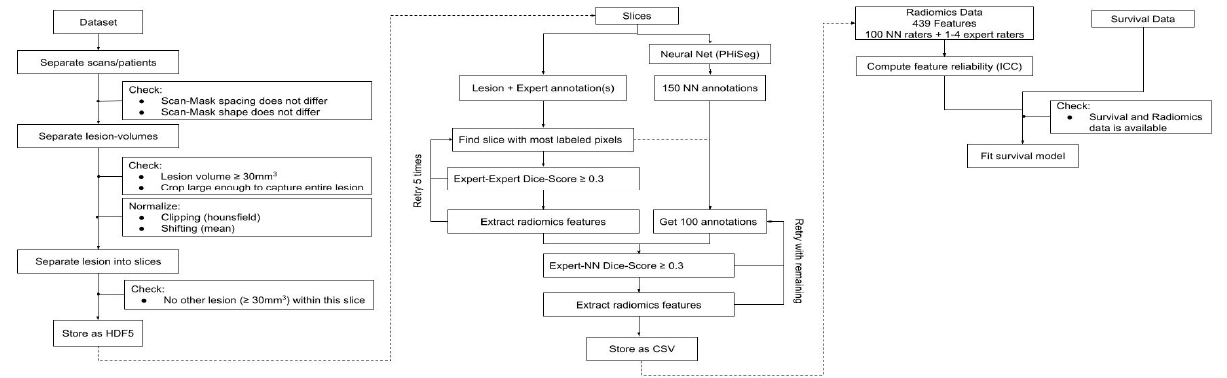
Figure A1. Data processing pipeline with inclusion and rejection criteria: first plausibility checks for the raw data were performed to ensure data integrity, then lesions were chosen that fulfill the inclusion criteria laid out in the text and slices were selected to be included in the study. Preprocessing for the BRATS data included normalizing of the z-scores (mean 0, standard deviation 1) and rescaling to [ − 500, 500] for the feature extraction. The Hounsfield units of the CT images were clipped as follows to: LITS and KITS [ − 200, 400], NSCLC [ − 1024, 200], LIDC [ − 500, 500].